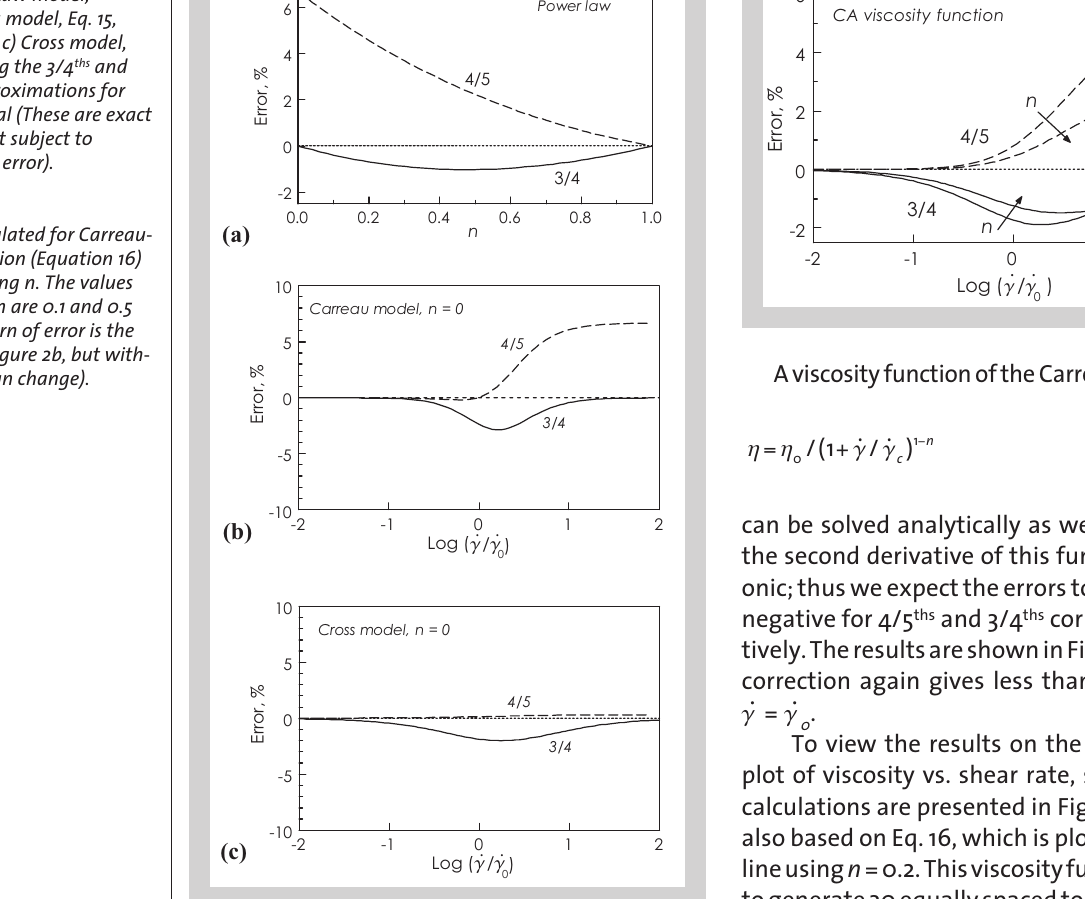
Figure 2 (left): Calculated error for a) Power-Law model, b) Carreau model, Eq. 15, n = 0, and c) Cross model, Eq. 14 using the 3/4 ths and 4/5 ths approximations for the integral (These are exact results, not subject to numerical error). Figure 3: Error calculated for Carreau- type function (Equation 16) with varying n. The values of n shown are 0.1 and 0.5 (The pattern of error is the same as Figure 2b, but with- out the sign